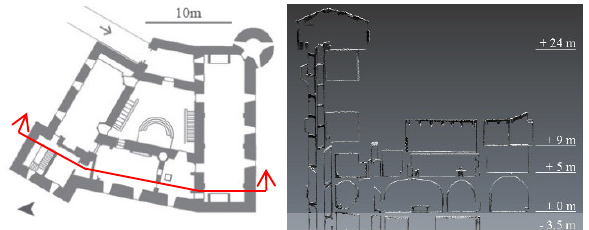
Figure 5. Section of the complexity in the vertical articulation of the Rocca apartments, from multiple ZEB scanning data (right). Schema of the ground floor of the Rocca, in red line, the vertical section (left).